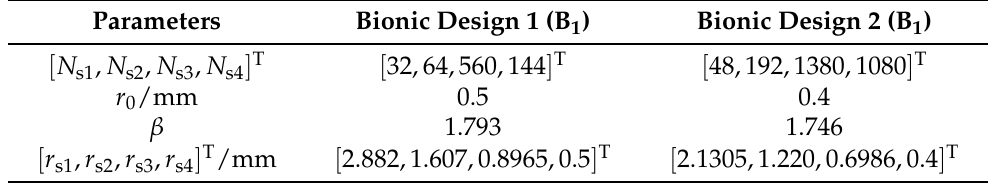
Table 2. The parameters of bionic design